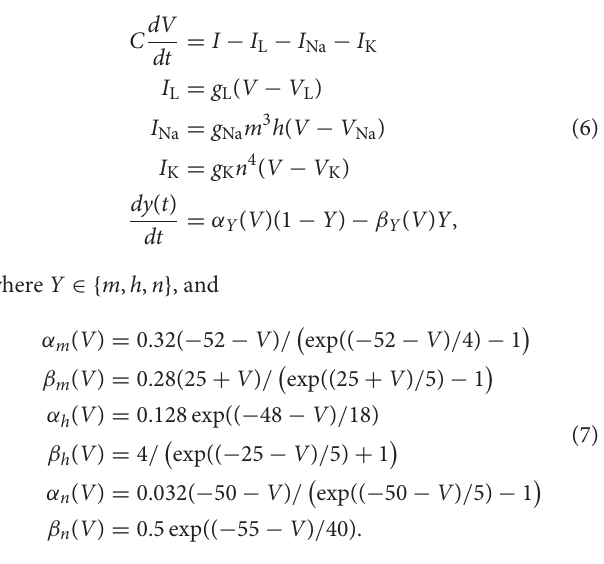
Algorithm 3: Condense terms smaller than threshold